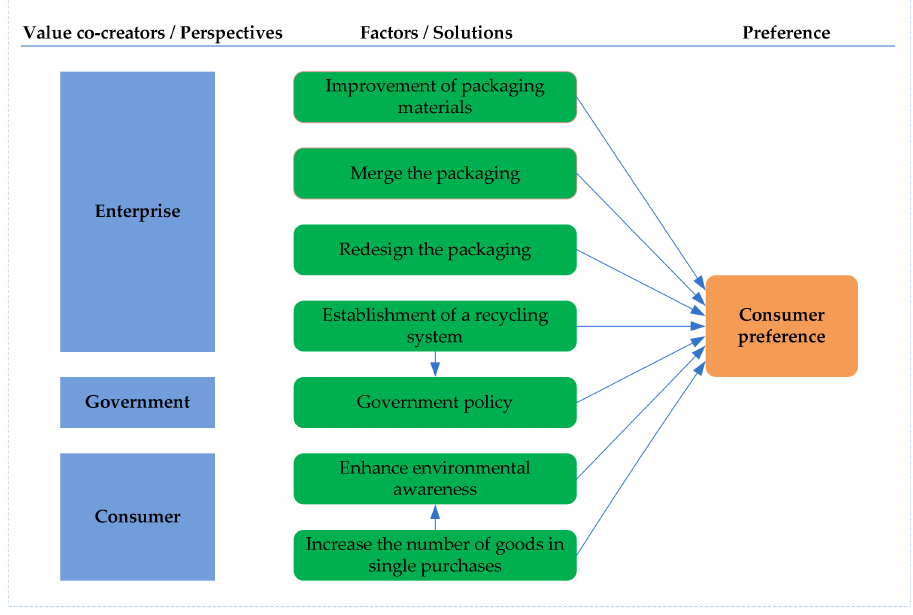
Figure 1. Consumer preference research model for e-commerce overpackaging